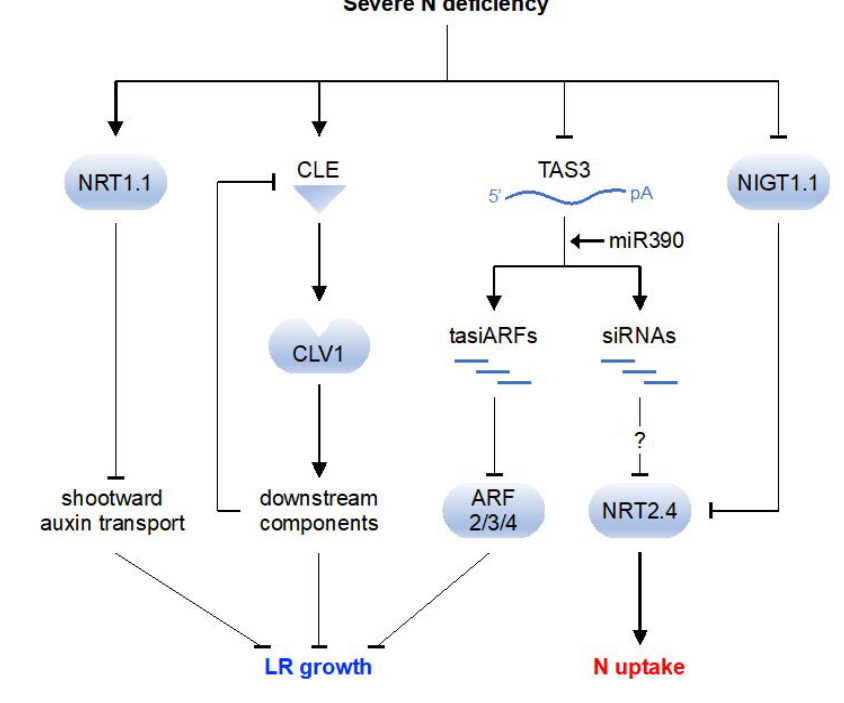
Figure 1. Signaling pathways modulating lateral root (LR) growth and N uptake under severe N deficiency in A. thaliana . Under low-N conditions, expression of TAS3 is suppressed; therefore, production of tasiARFs is reduced [30]. As a result, expression of ARF2 / 3 / 4 is derepressed and LR growth is inhibited [98]. Inhibition of LR growth is also controlled by NRT1.1-mediated auxin transport [21] and the CLE–CLAVATA1 (CLV1) peptide–receptor signaling module [22]. On the other hand, TAS3 down-regulates expression of NRT2.4 by inducing cleavage of NRT2.4 mRNA [30]. Considering that NRT2.4 is transcriptionally suppressed by NIGT1.1 [14], TAS3 might act to enhance suppression. pA, poly A